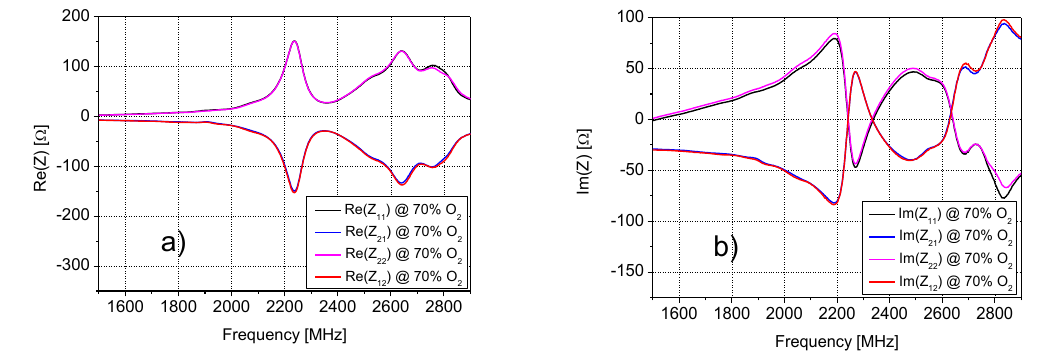
Figure 4. Illustration of the experimental set-up. It consists of five main blocks: (1) the controlled gas system, (2) the measurement chamber, (3) the vector network analyzer, (4) the USB/GPIB interface, and (5) the graphical user interface.